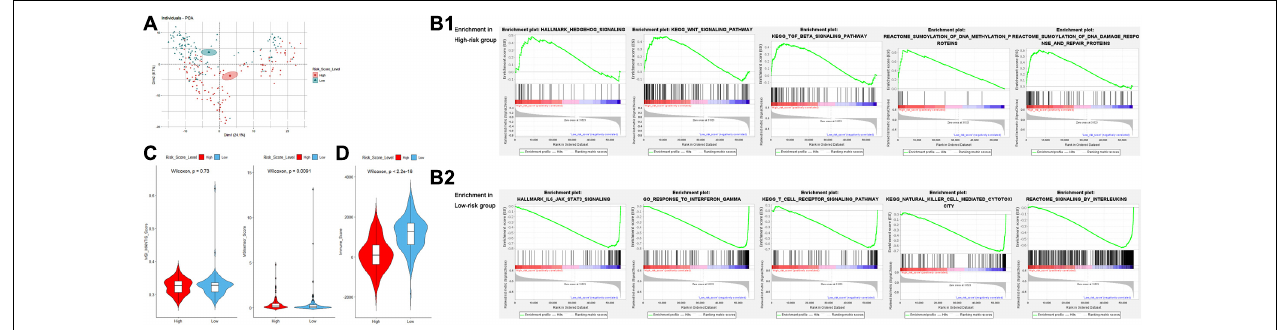
FIGURE 8 | (A) Principal component analysis for examination of the gene expression diversity between the high- and low-risk groups. (B) Gene set enrichment analysis of the high- (B1) and low- (B2) risk groups. (C) Violin plots for the difference of MANTIS and MSIsensor scores between the high- and low-risk groups. (D) Violin plots for the difference of ESTIMATE-Immune scores between the high- and low-risk